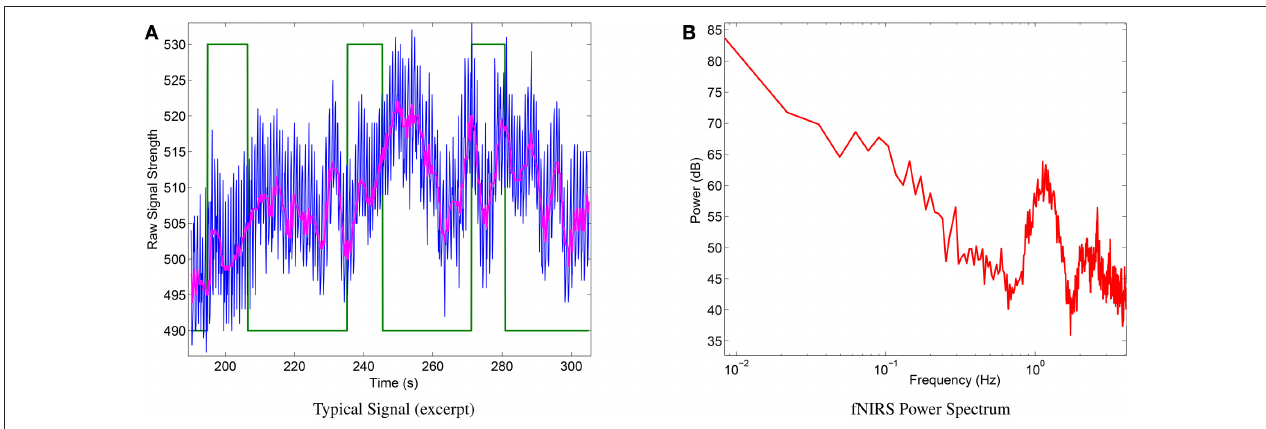
FIGURE 8 | (A) Excerpt of typical raw signal (blue) during mental arithmetics. Green line: binary label (high states: m. arithmetics. low states: relax), magenta line: median filtered signal). (B) Typical power spectrum of raw signal of the same subject and complete session, showing expected shape (power spectrum follows power law) and deviations caused by systemic artifacts.